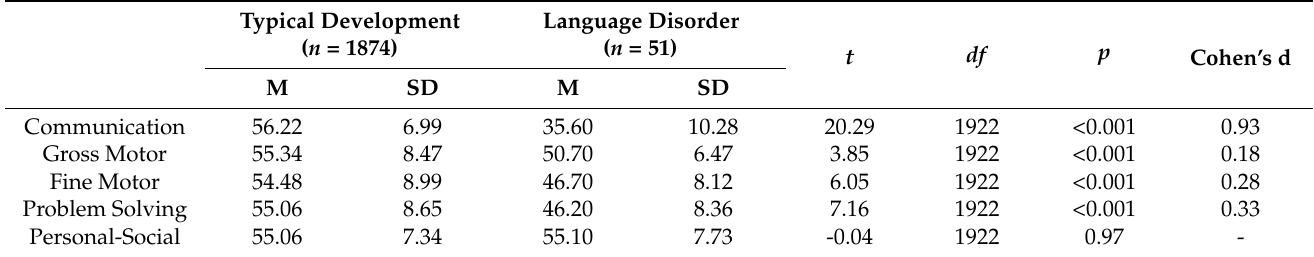
Table 8. Comparison group between children with Language Disorder and Typical Development on ASQ-3.